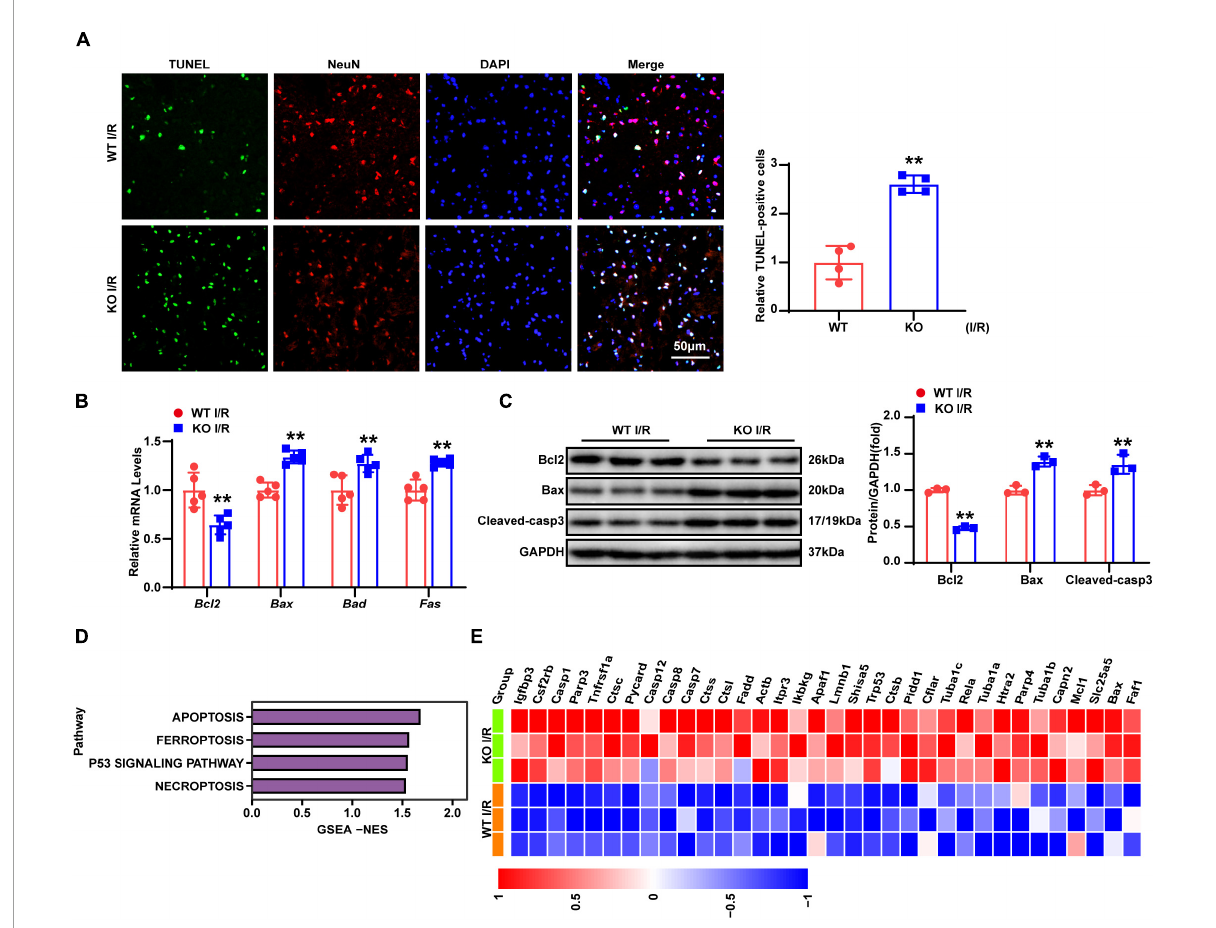
FIGURE4 LAPTM5 deletion promotes neuronal apoptosis induced by cerebral I/R injury. (A) Representative images of brain co-stained for TUNEL (green), NeuN (red), and DAPI (blue), and the right panels (quantification) showed more apoptotic neurons in the LAPTM5-KO group after I/R. n = 4 mice per group, ** p < 0.01 vs. WT I/R. Scale bar, 50 µ m. (B) RT-qPCR showed decreased expression of anti-apoptotic genes ( Bcl2 ), while pro-apoptotic genes ( Bax, Bad, and Fas ) expression were increased in the LAPTM5-KO group after I/R, n = 5 mice per group, ** p < 0.01 vs. WT I/R. (C) Western blot showed decreased expression of anti-apoptotic proteins (Bcl2), while pro-apoptotic proteins (Bax and Cleaved-caspase 3) were increased in LAPTM5-KO mice after I/R injury. n = 3 mice per group, ** p < 0.01 vs. WT I/R. (D) GSEA showed the expression levels of